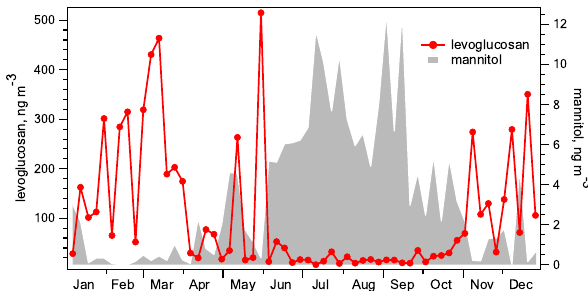
Fig. 2. Mean concentrations of levoglucosan and mannitol for all the sites in